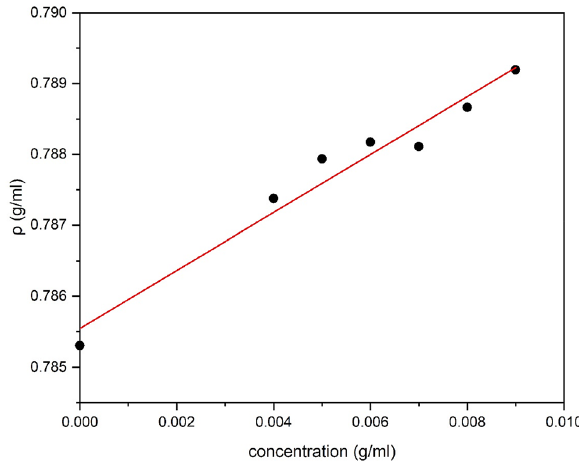
Figure 2. Solution density of TPA5 in isopropanol plotted against